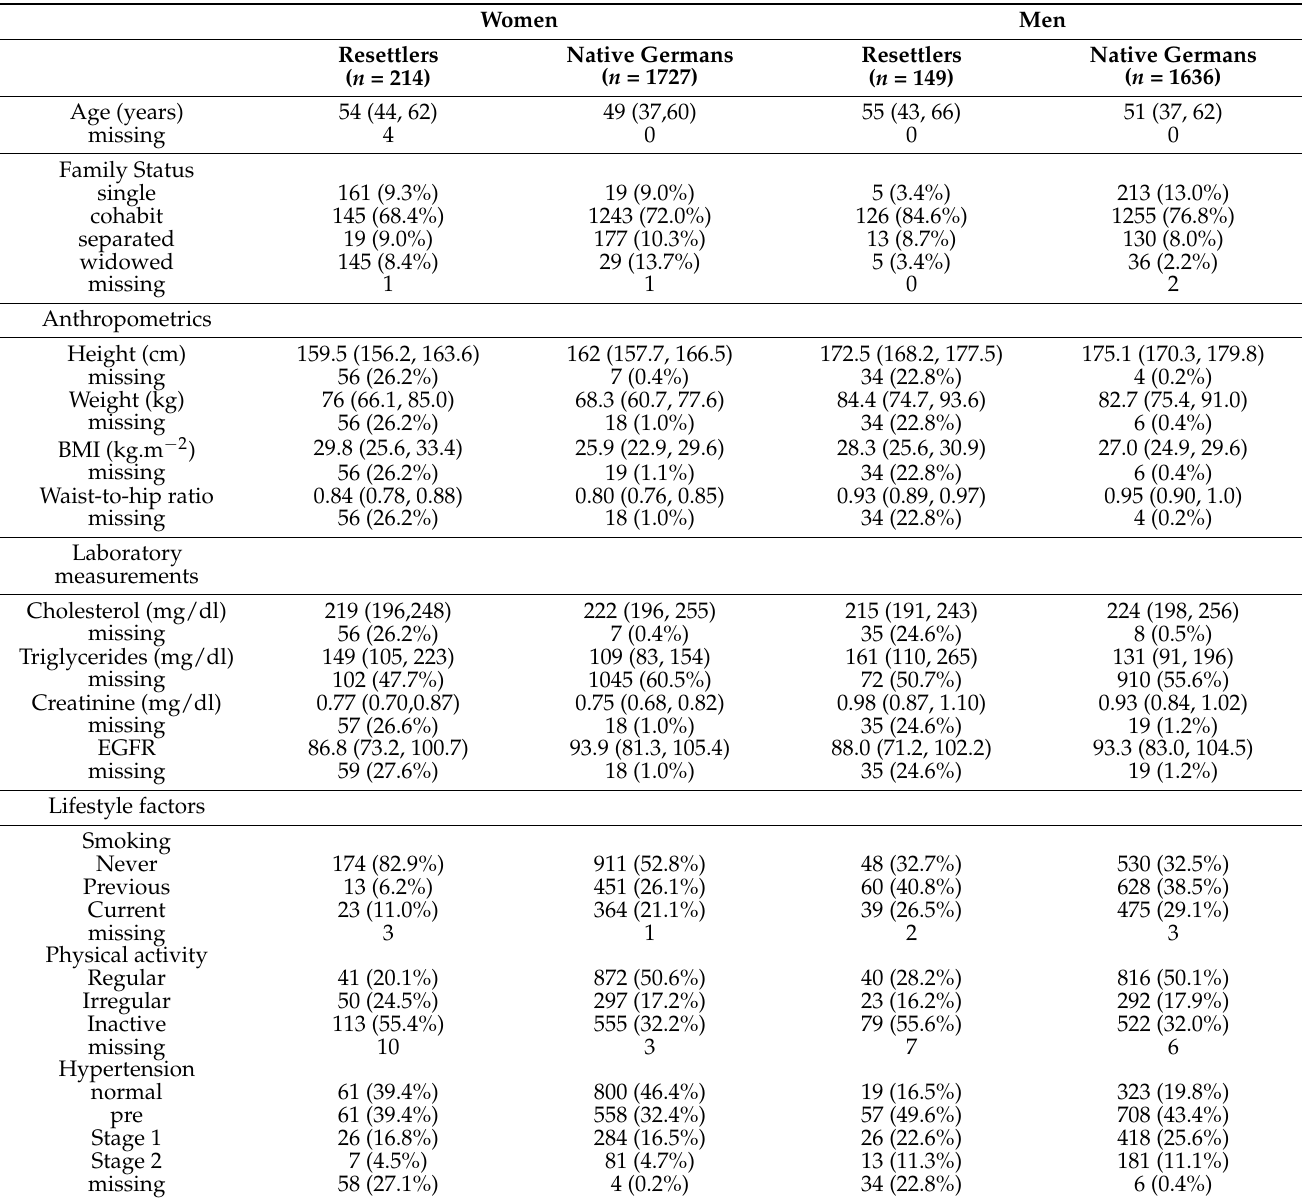
Table 1. Population characteristics of the resettlers and native Germans, stratified by sex. Women Men Native Germans Resettlers ( n = ( n = 214)